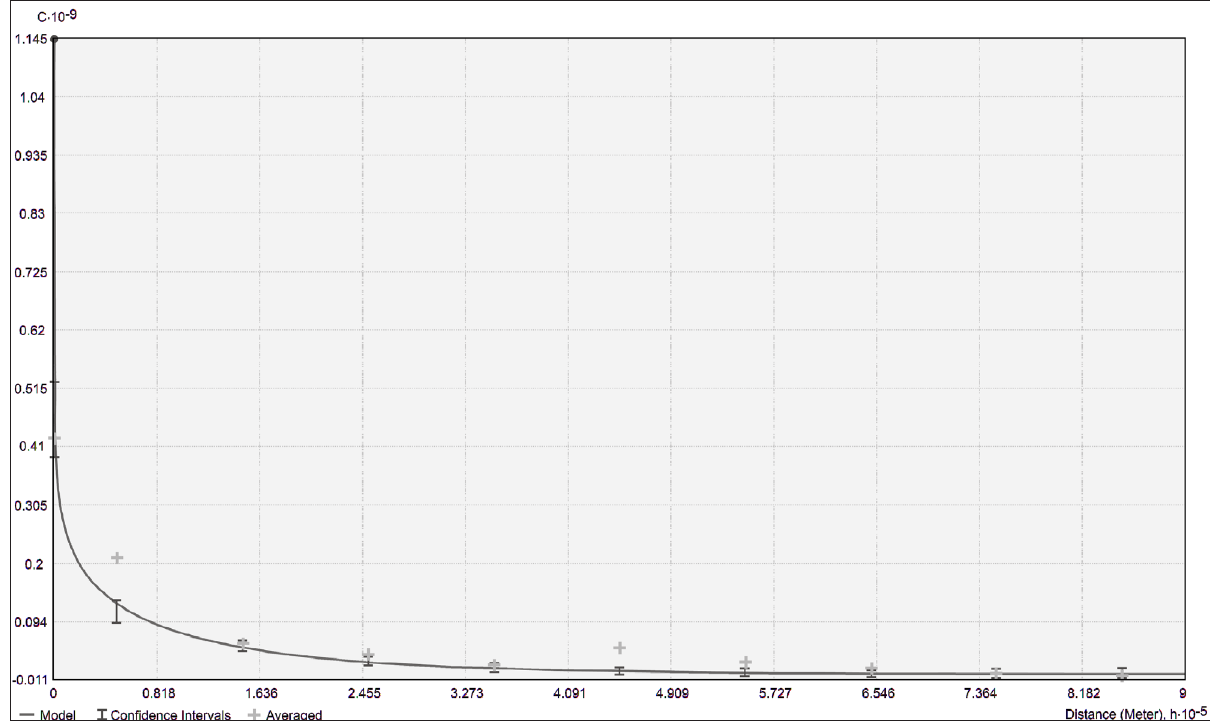
Figure 4: Variogram of the 1996 unemployment data.